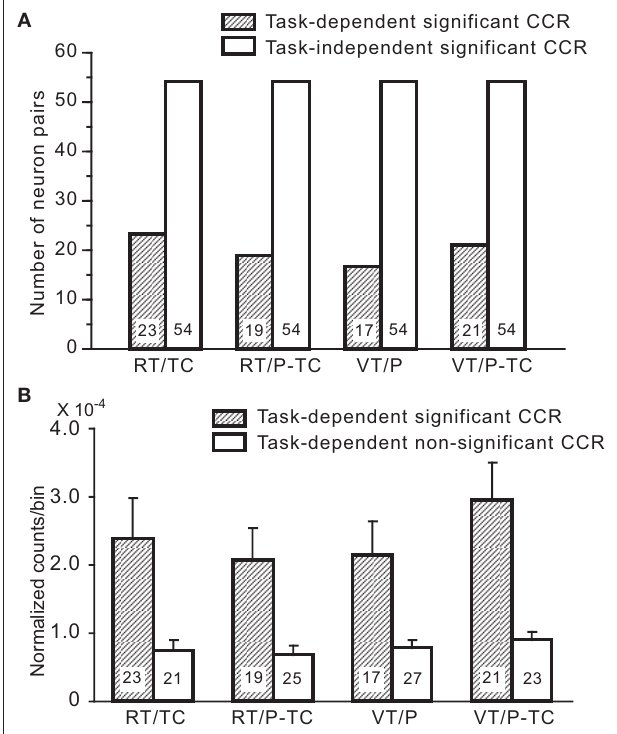
Figure 12 | Characteristics of the neuron pairs with the task-dependent CCg peaks. (A) Frequency histogram of task-dependent and task- independent significant CCG peaks in each task. By definition, the same numbers of task-independent significant CCRs were found in all tasks. (B) Comparison of mean normalized counts between –50 and + 50 ms in the CCRs between task-dependent significant and non-significant CCG peaks. Numbers of the neuron pairs are indicated in each